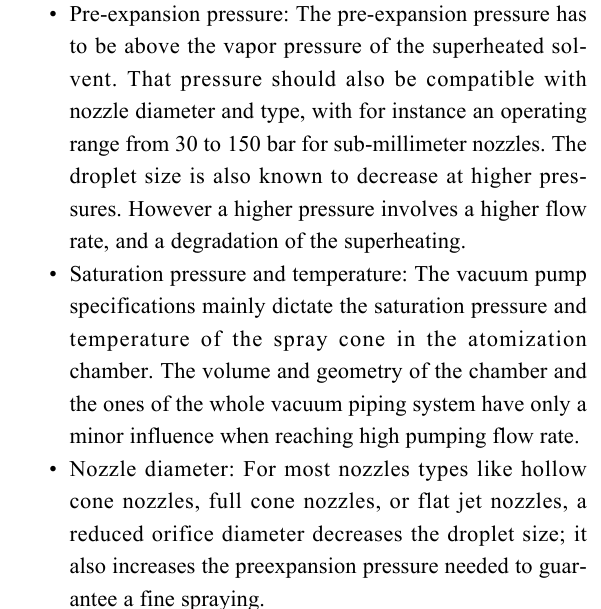
condenser after the pump can recover the solvent for industrial installations. The standard operating conditions are: 40 bar of inlet pressure, 160 °C at the hollow cone nozzle, and an orifice diameter of 60 μ